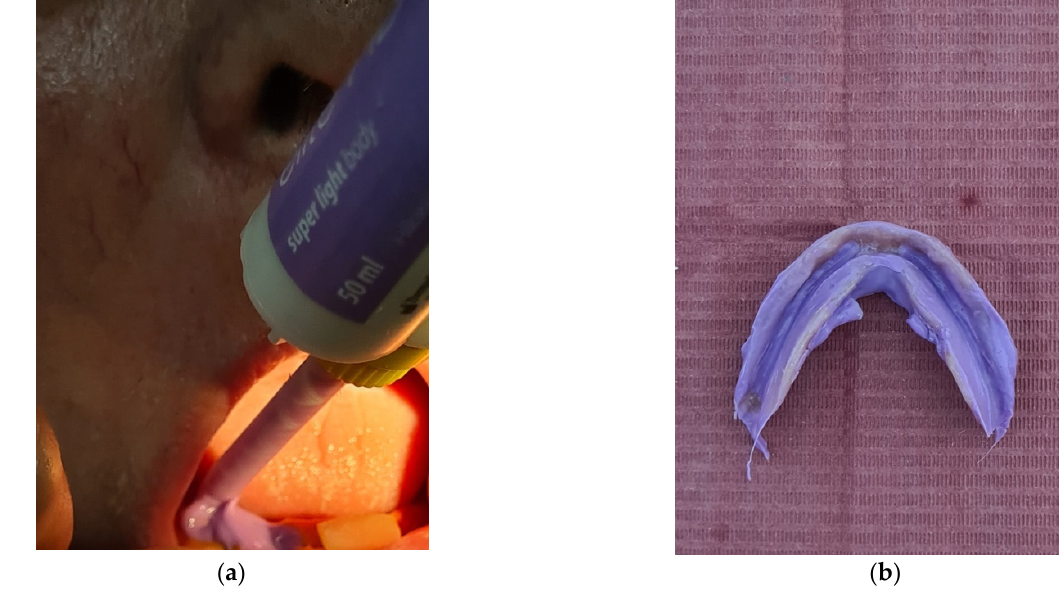
Figure 14. ( a ) applying the impression material on the flabby mucosa; ( b ) final lower impression. Following the determination of the occlusal relations, the balanced occlusion was performed. The final denture has a good suction, it is esthetic, the adaptation of the patient being made easily. The final result is a correct one, the patient being satisfied with the restoration of the mastication, esthetic and phonetic functions (Figures 15 and 16).